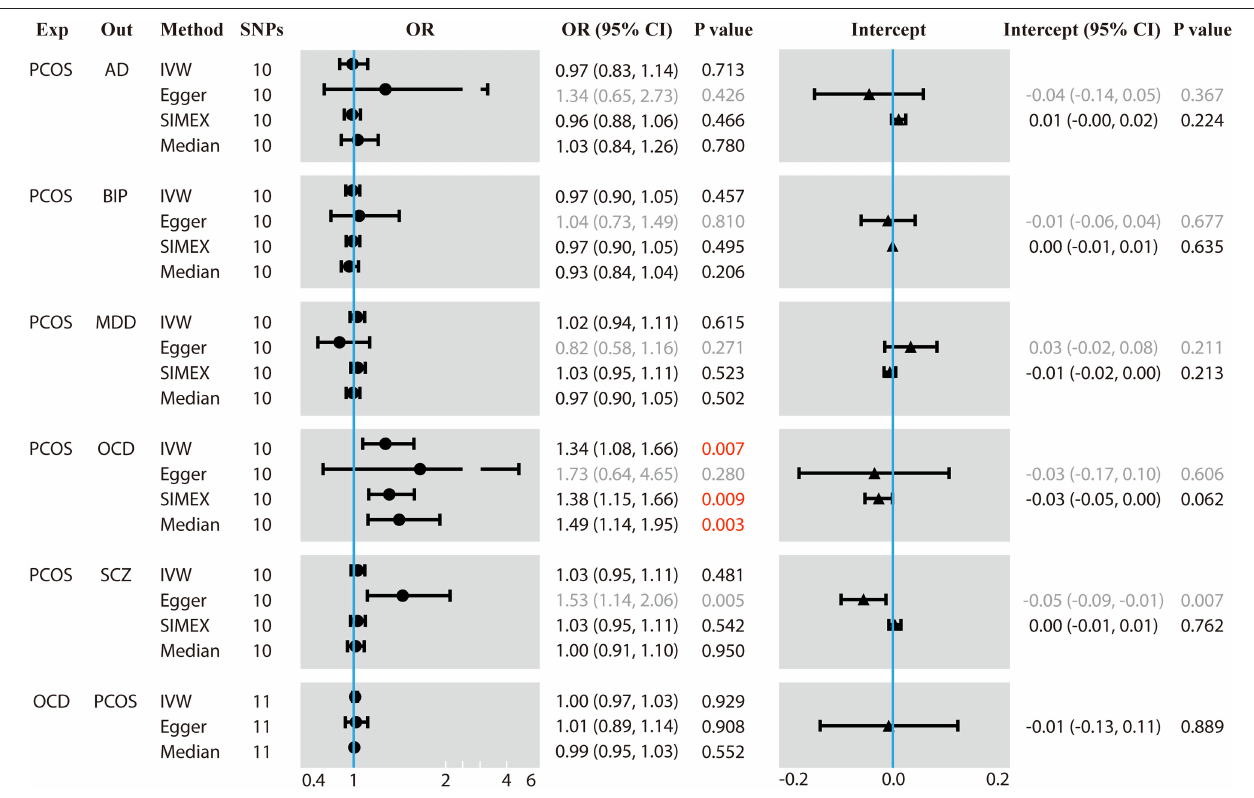
FIGURE 1 | Results of forward and reverse Mendelian randomization (MR) analyses. Two-sample MR analysis showing the effect of the exposure on the outcome using single-nucleotide polymorphisms (SNPs) significant at p < 5 × 10 − 8 . Exp, exposure; Out, outcome; SNPs, number of the SNPs used in MR analysis; OR, odds ratio; CI, confidence interval; PCOS, polycystic ovary syndrome; AD, anxiety disorder; BIP, bipolar disorder; MDD, major depression disorder; OCD, obsessive compulsive disorder; SCZ, schizophrenia. The regression dilution I 2 statistics between PCOS exposure and each of the five psychiatric disorders were < 90%, which made the results of the Egger method inaccurate. Therefore, simulation extrapolation (SIMEX) correction was applied. OR values are binary, while the intercept values are continuous. Values in red mean that they are statistically